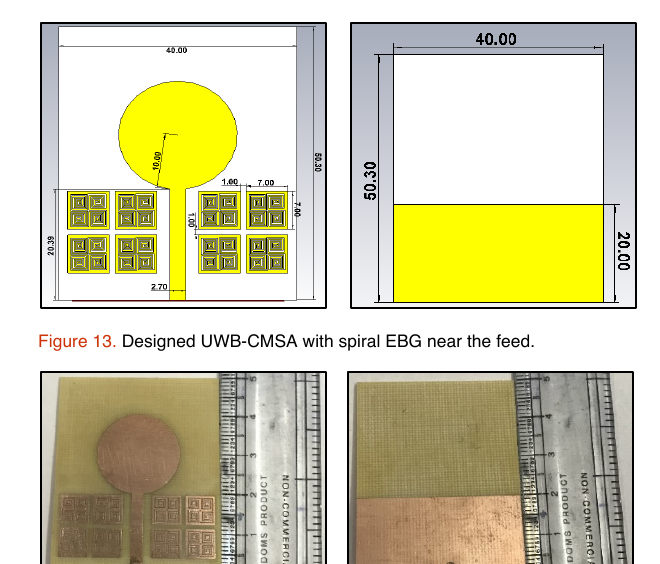
Figure 11. Surface current at 2.4 GHz for CMSA with and without EBG.